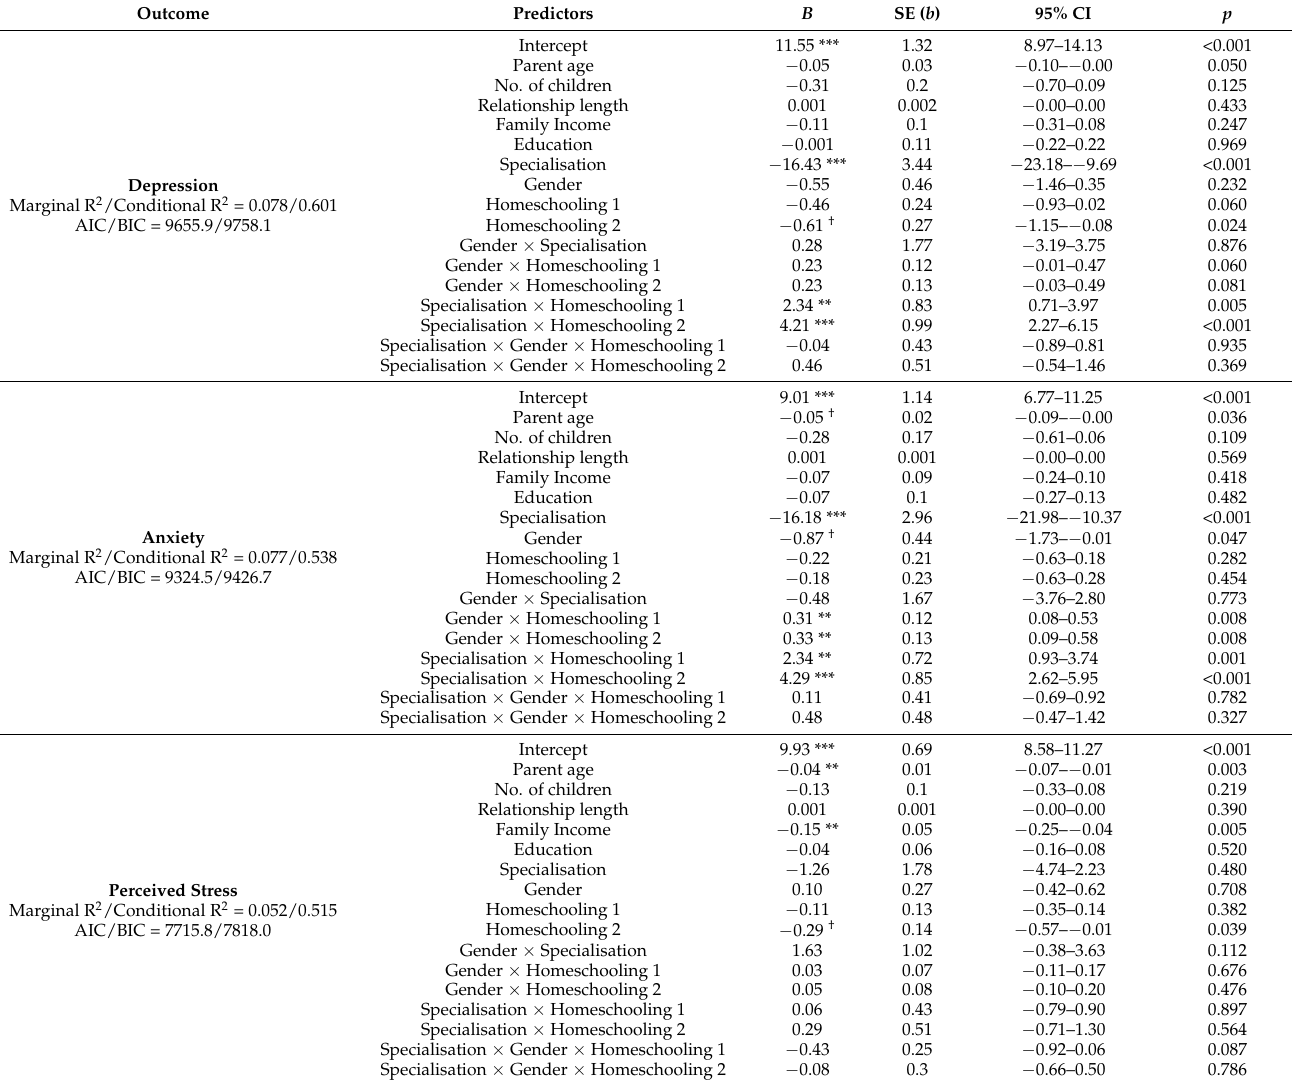
Table 9. Effects of specialisation and homeschooling status on male vs. female parents’ well-being in mixed-sex